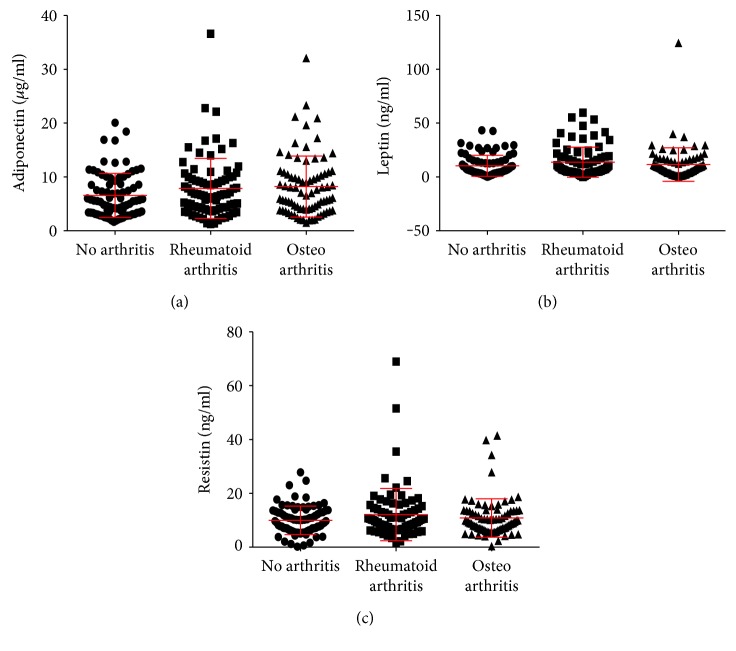
Plasma (a) adiponectin, (b) leptin, and (c) resistin in participants without arthritis, with rheumatoid arthritis, and with osteoarthritis. Horizontal lines represent means ± standard deviations, and dots, squares, and triangles represent individual data points from participants without arthritis, with rheumatoid arthritis, and with osteoarthritis, respectively. Data are not statistically different as determined by the Kruskal-Wallis test.